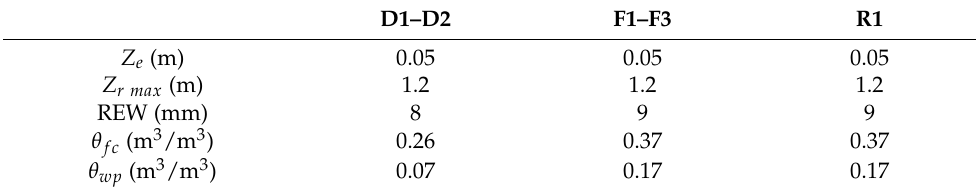
Table A2. The FAO-56 parameters used for the studied